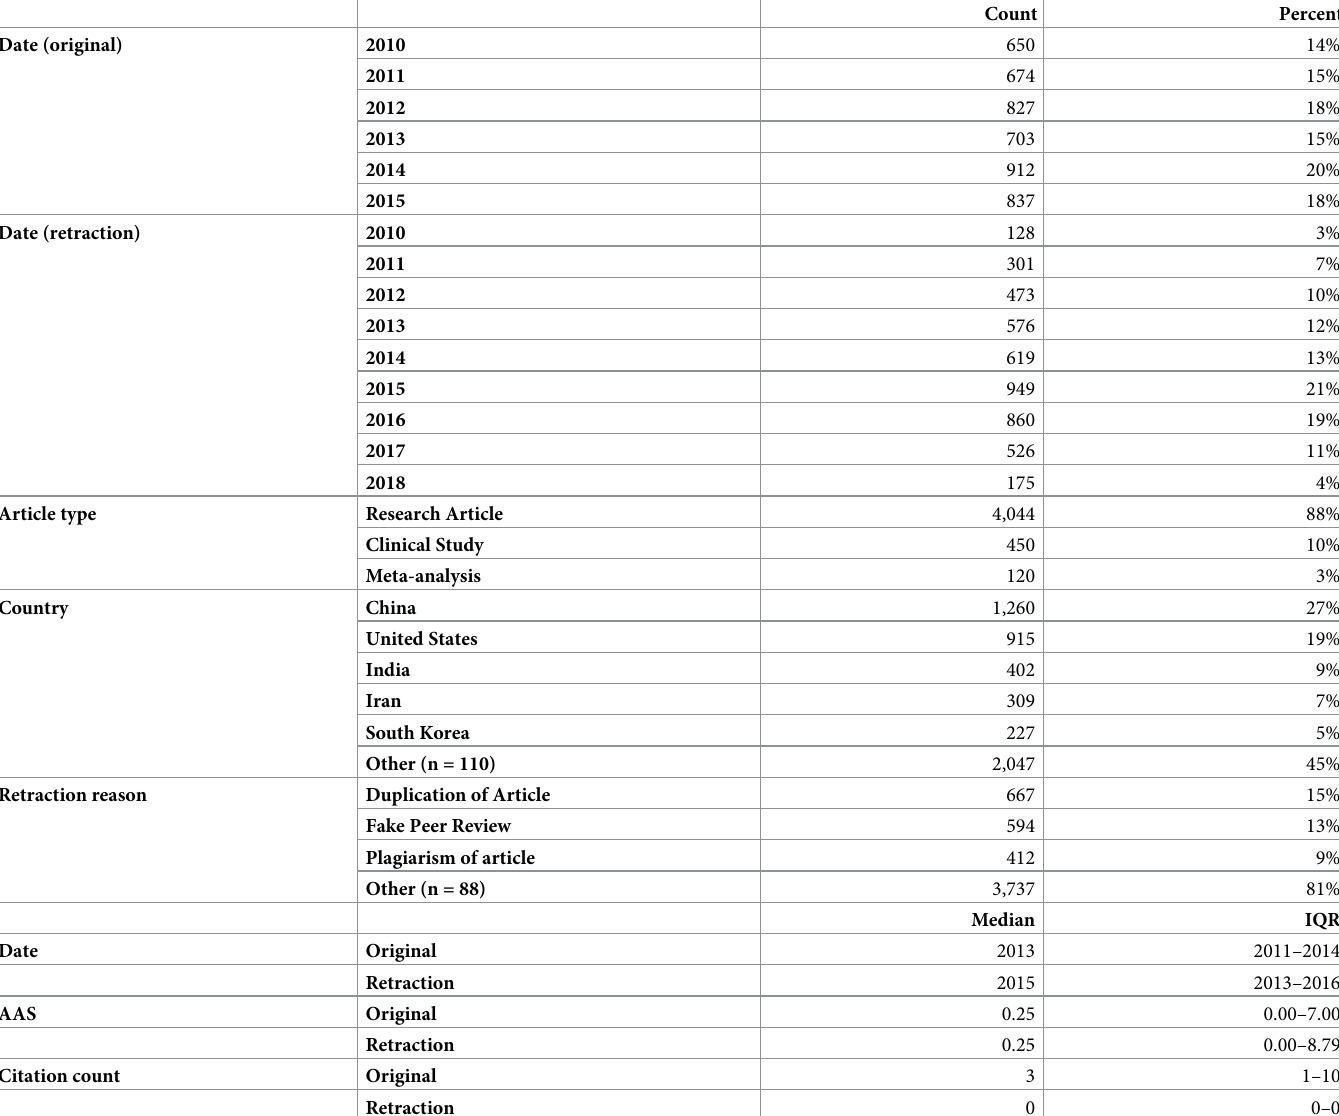
Table 1. Descriptive statistics for 4,603 unique eligible research